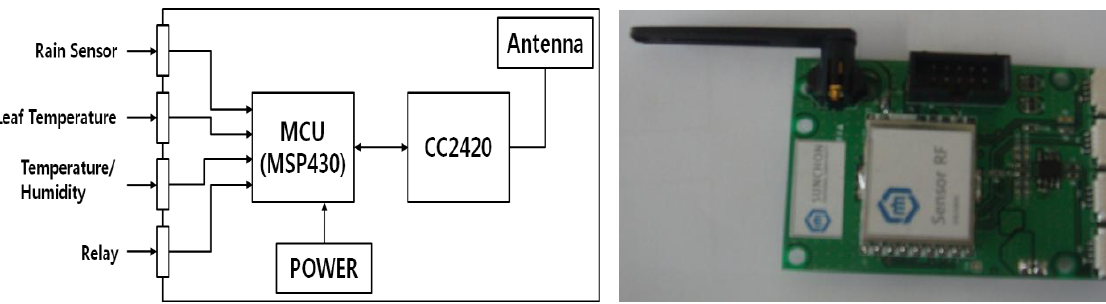
Figure 2. Block diagram of the sensor node and the as-manufactured sensor node.